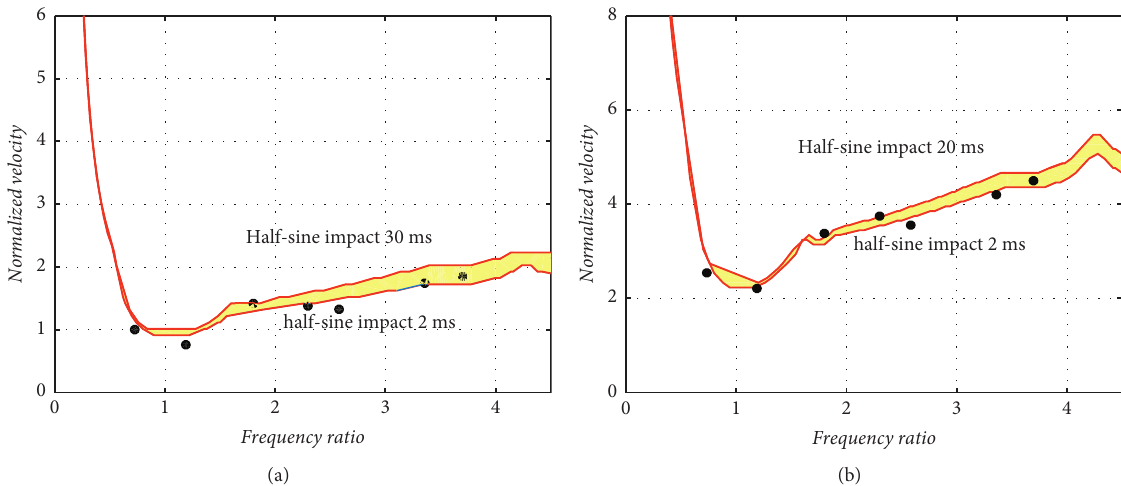
Figure 12: DDBCs of a packaging system with linear stiffness under half-sine pulses for different durations. (a) 2 g . (b) 5 g